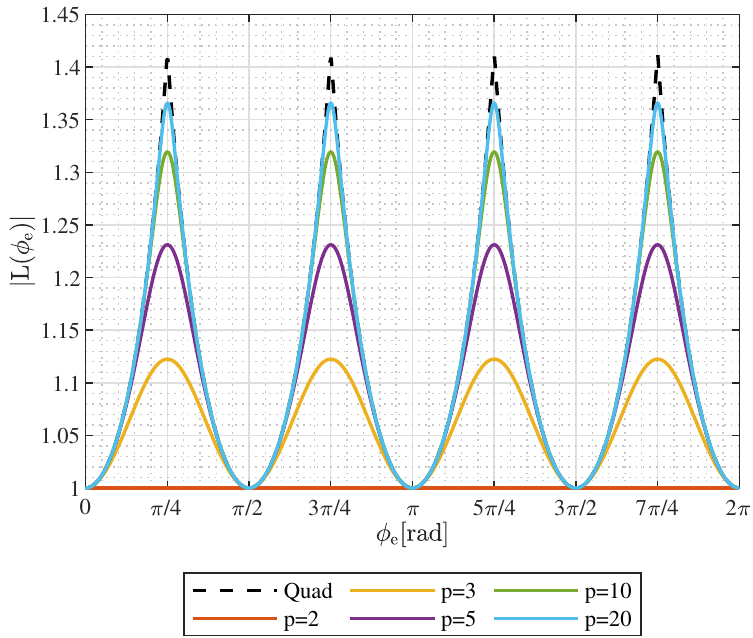
Figure 4. Phasor length for different values of p